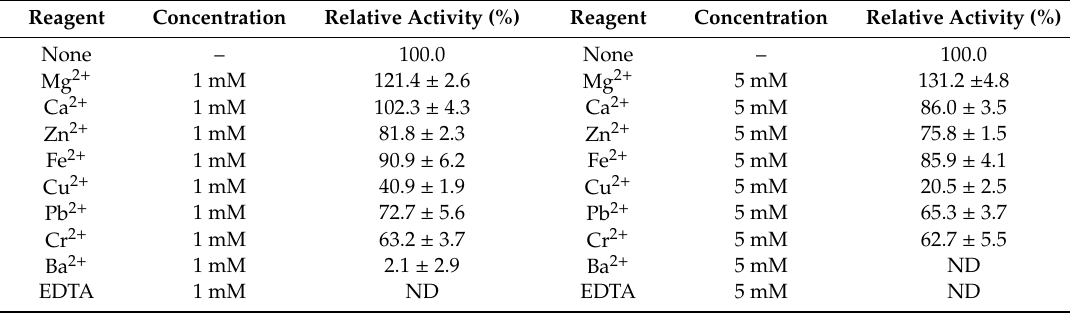
Table 2. E ff ect of various reagents on the rPsRNR activity.